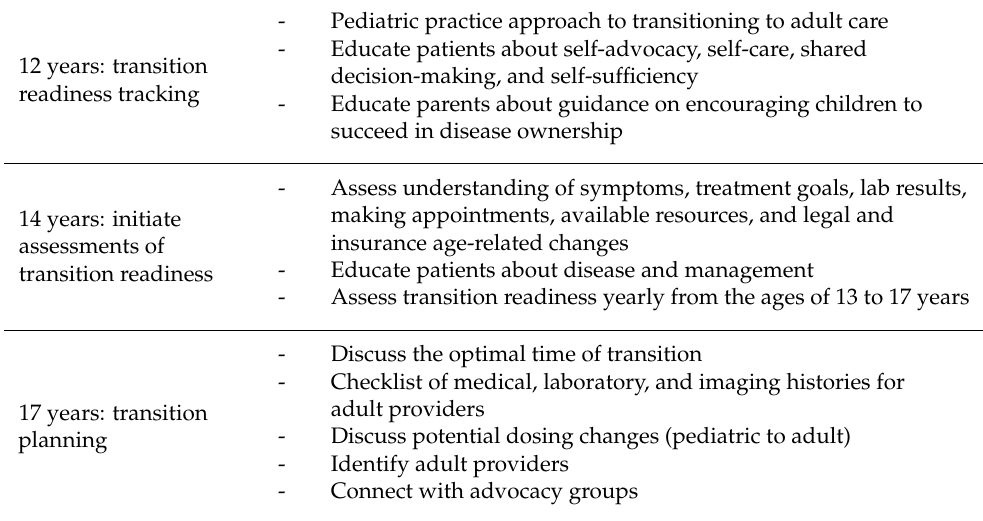
Table 2. Simple timelines of transfer